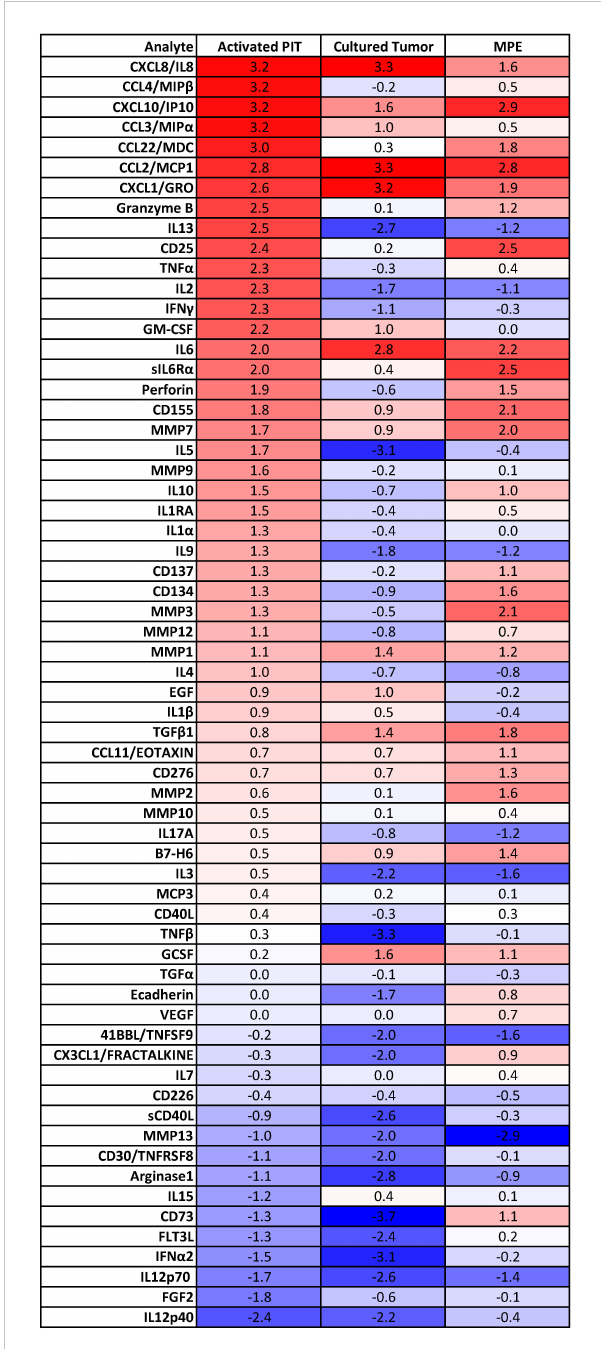
FIGURE 2 Secretome of culture supernatants of in vitro activated PIT (n=10), primary MPE tumor cell cultures (n=39) and MPE cell-free fl uid (n=396). Data within heatmap boxes are expressed as log 10 picomolar mean concentrations because of the disparity in cytokine and chemokine molecular masses, where bright red indicates approximately 2000 pM, white indicates 2 pM and blue indicates 0.002 pM. Cytokine and chemokine molecular masses were determined from the literature and do not account for isoforms, glycosylation or other sources of